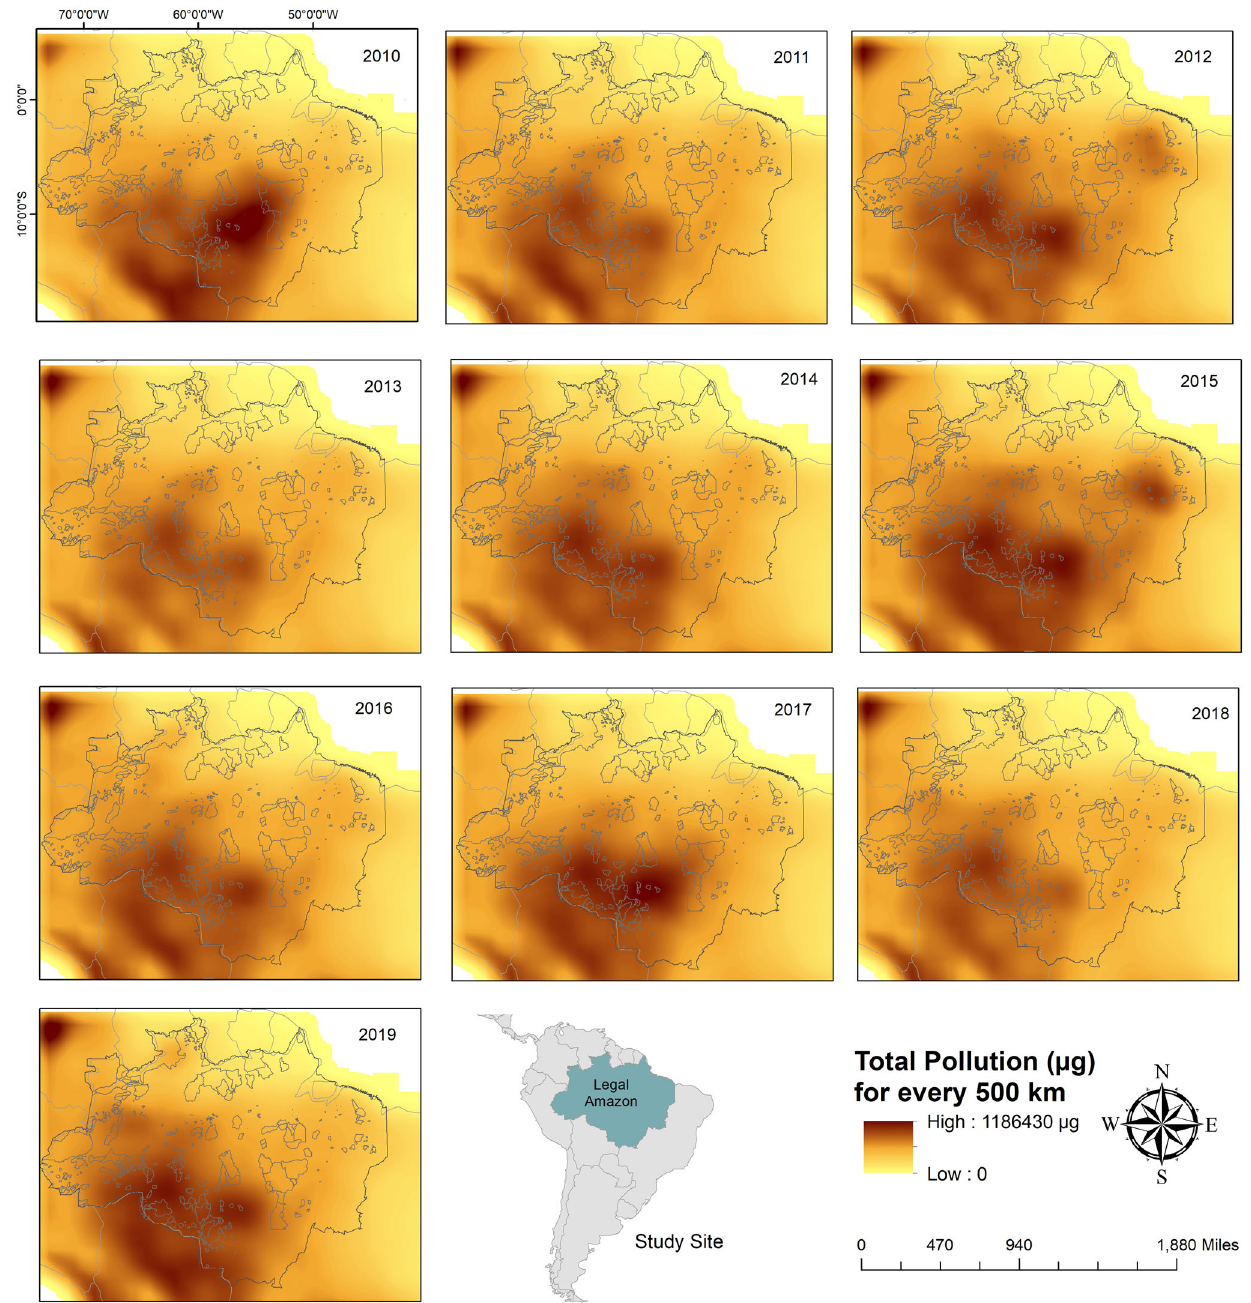
Fig. 1 PM 2.5 temporal trends. Temporal trends of PM 2.5 released by forest fi res (in µ g) in the Brazilian Legal Amazon, with the wind dispersion effect of 500 km square, and the study area location. The Brazilian Legal Amazon boundary is shown in gray on the maps, together with the Indigenous territories present in the